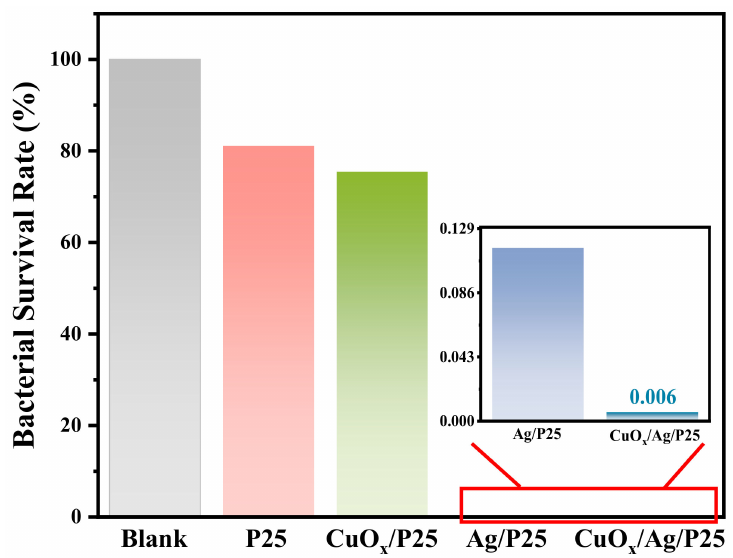
Figure 7. Comparison diagram of the bacterial survival rate in the media with different